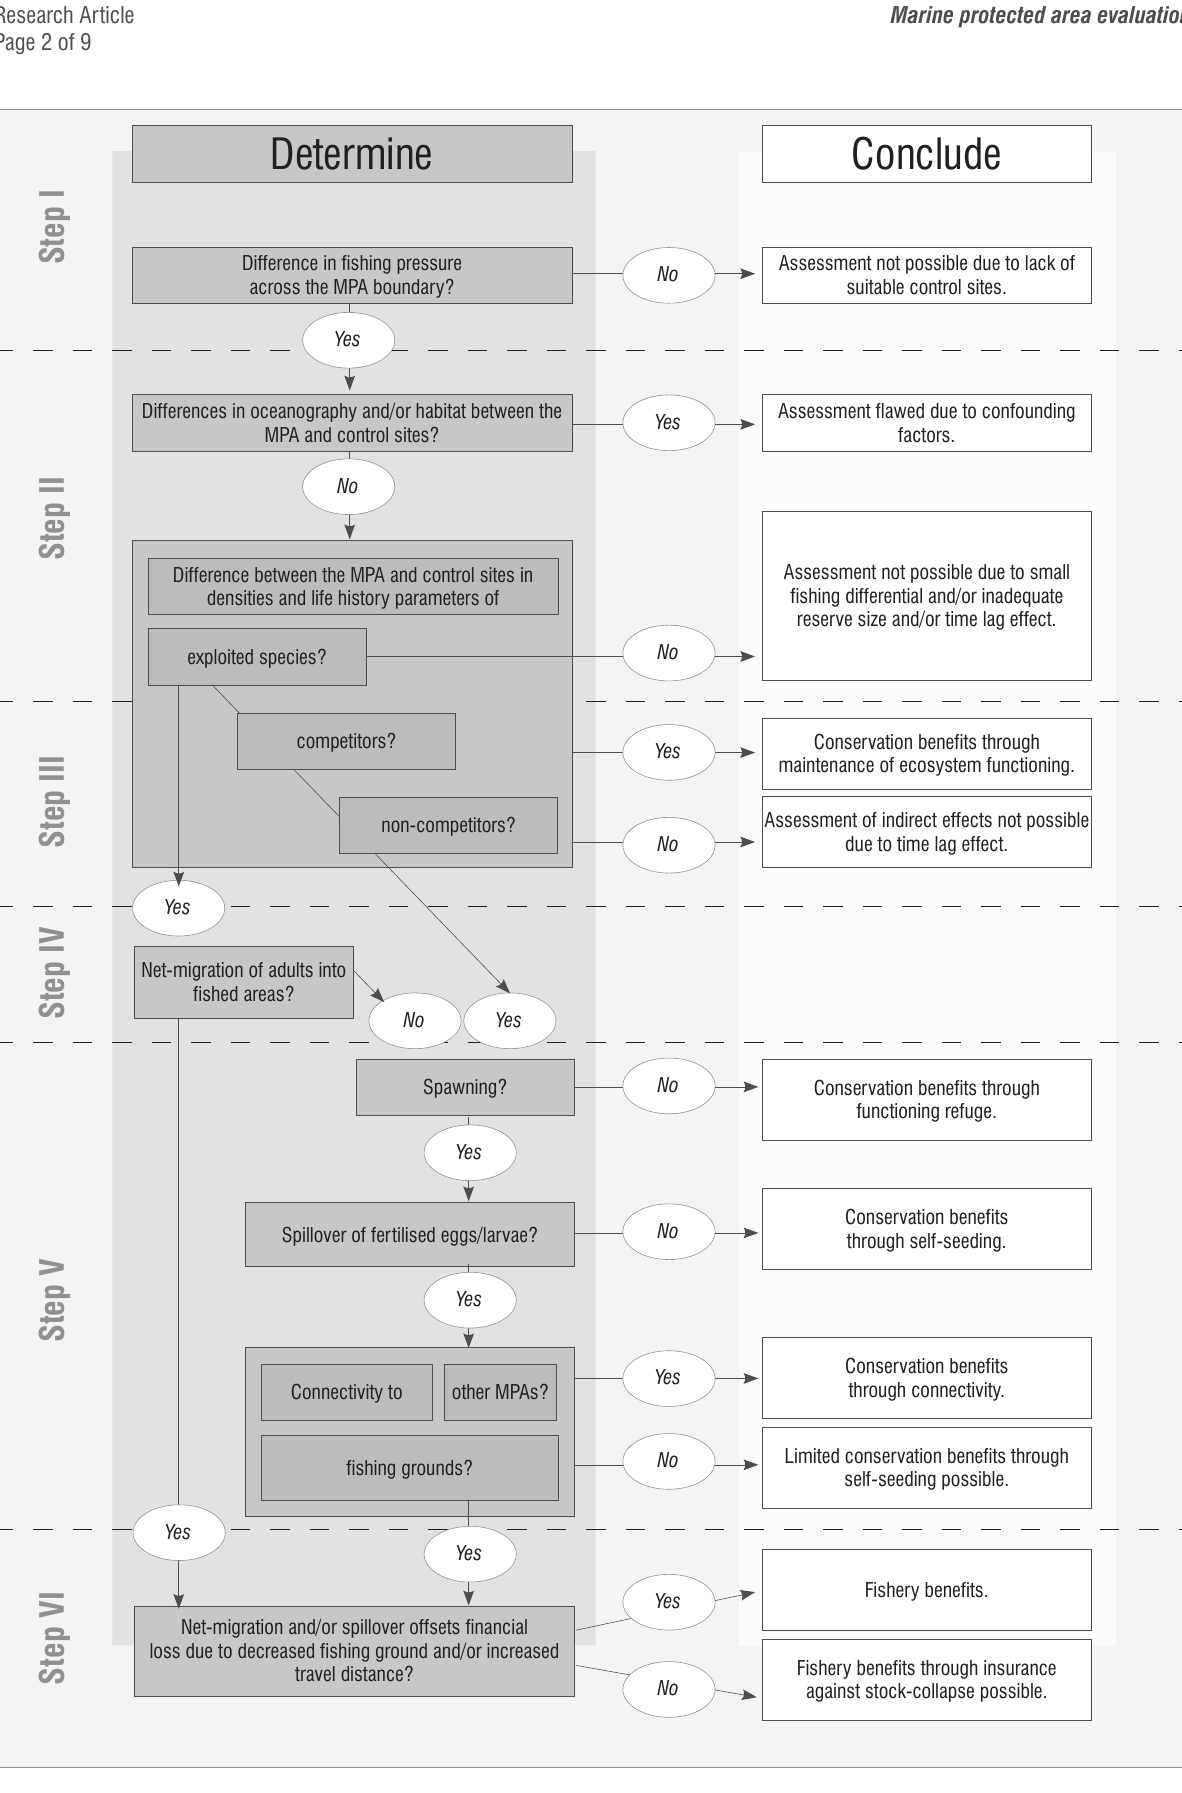
Figure 1: The marine protected area (MPA) assessment ‘tool box’ summarises and relates the criteria necessary to evaluate the effectiveness of a MPA in six consecutive